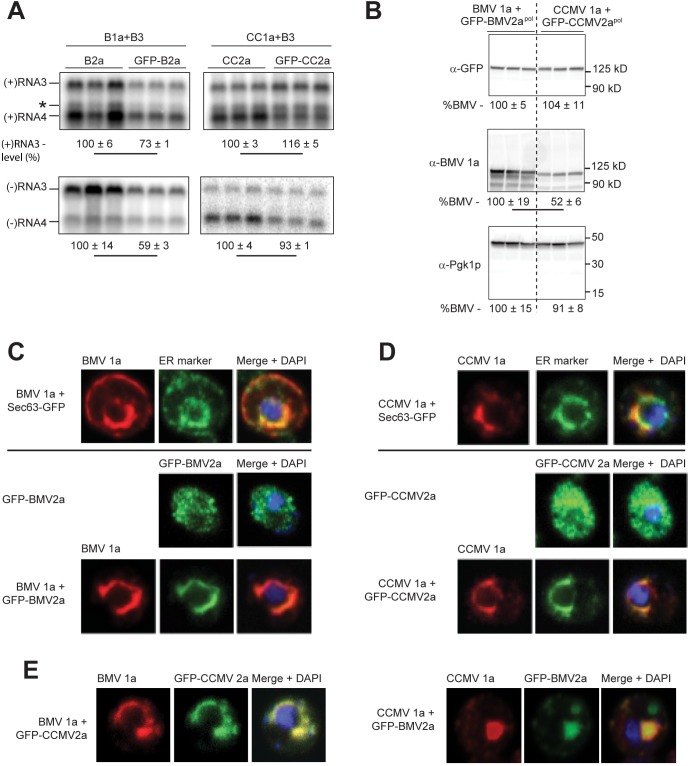
CCMV 1a localizes to the perinuclear ER and recruits CCMV 2a.(A) Replication of BMV RNA3 by BMV and CCMV with untagged 2a and GFP-2a was detected by northern blotting. (B) Western blotting was performed on total protein lysate from yeast expressing BMV 1a and GFP-BMV 2a or CCMV 1a and GFP-CCMV 2a using the antibodies indicated. Pgk1p is an endogenous yeast protein used as a loading control. The average and standard deviation of three replicates is shown beneath the lanes. A line connecting two numbers indicates a statistically significant difference (p<0.05). (C) Fluorescence confocal microscopy was used to image cells expressing BMV 1a (red) and Sec63-GFP (ER marker), BMV GFP-2a (green) only, or BMV 1a and BMV GFP-2a. DNA was stained with DAPI as a nuclear marker. (D,E) As for (B) with (D) CCMV 1a and CCMV GFP-2a or (E) the heterologous 1a/2a combinations as indicated. All images are projections of a confocal z-stack.